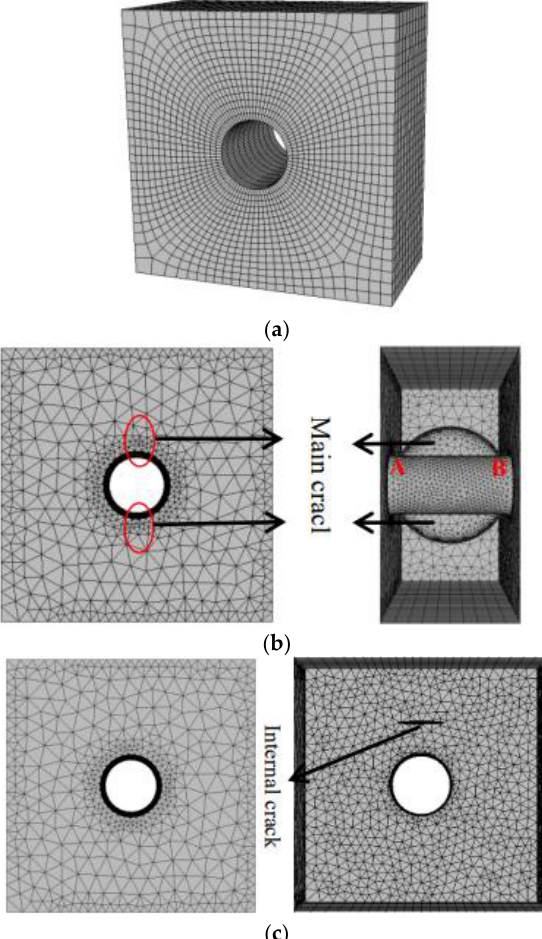
Figure 15. Model mesh division. ( a ) Model 1: Complete orifice model; ( b ) Model 2: Main crack initiation model; ( c ) Model 3: Model with internal cracks. A and B are the start and end point of the crack front.